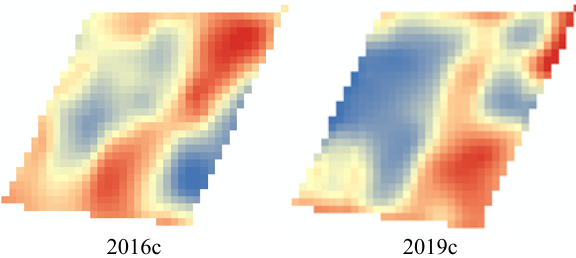
Figure 9. Inversion Results of Area 2 Surface Temperature According to the results of Area 1 and Area 2, increasing the greening area around the room area can effectively reduce the amount of heat emitted. The results of area 3 show that if the surrounding of the housing area is afforested reasonably,